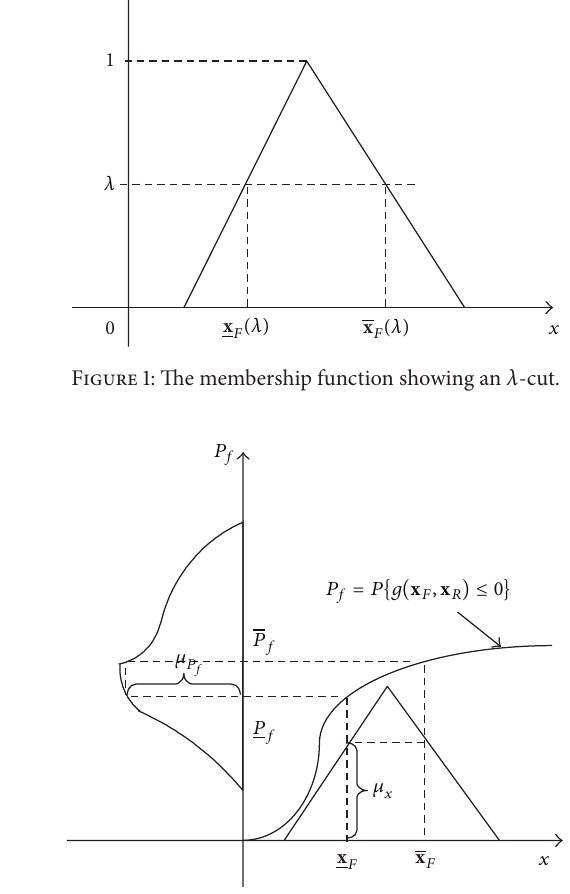
Figure 2: Transformation technique of membership